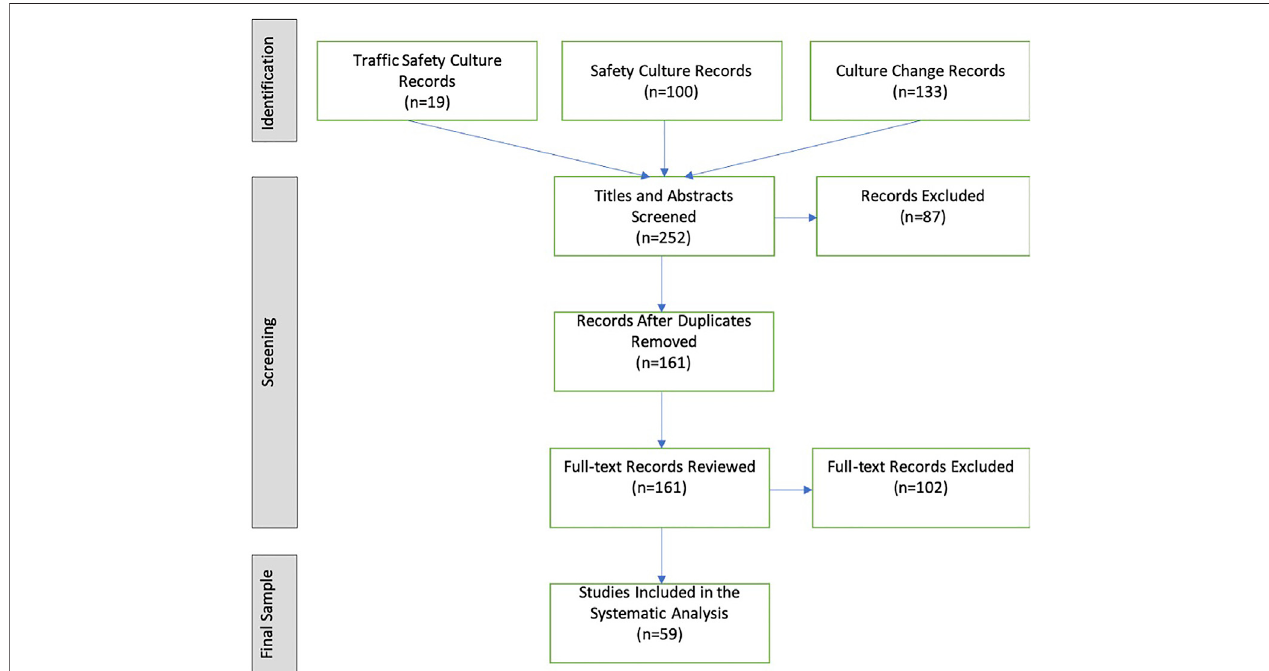
FIGURE 1 | Search and screening